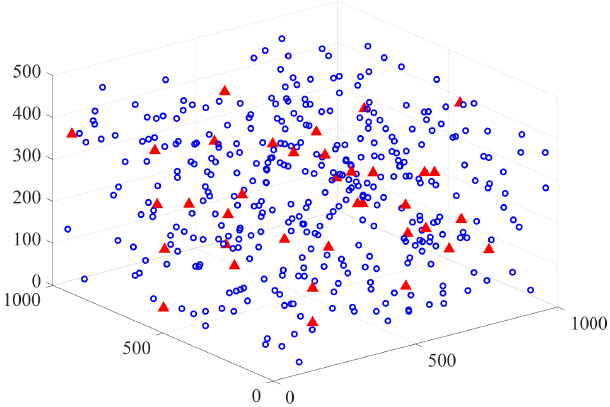
Figure 5. Deployment of sensor and anchor nodes in a 3D